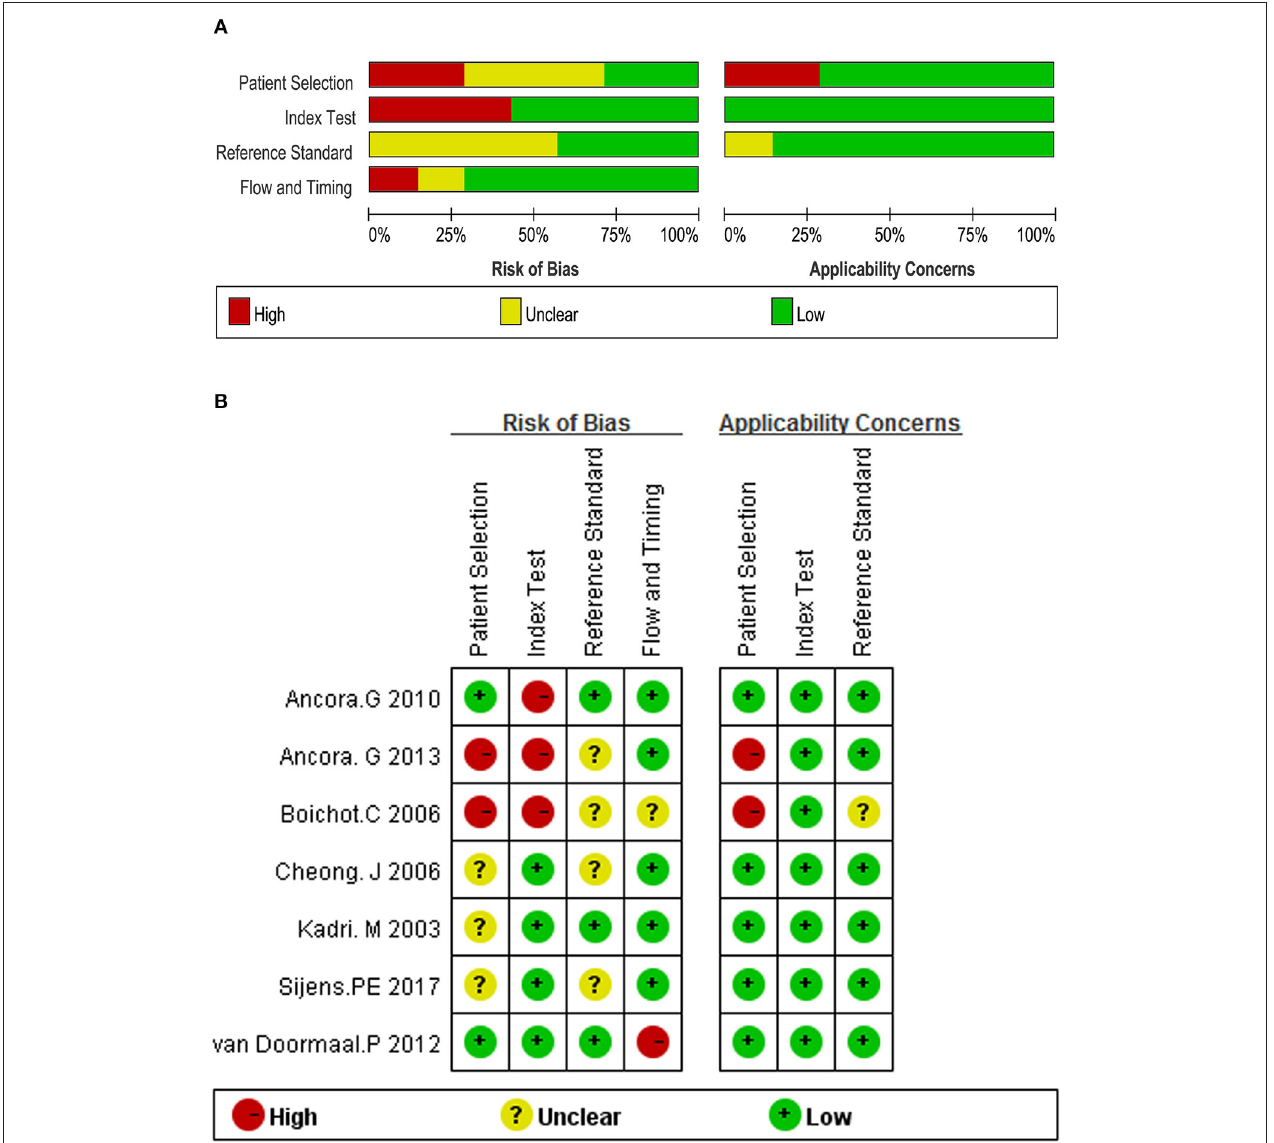
FIGURE 2 | Quality assessment according to QUADAS-2 of the included studies (A) overall and (B) by